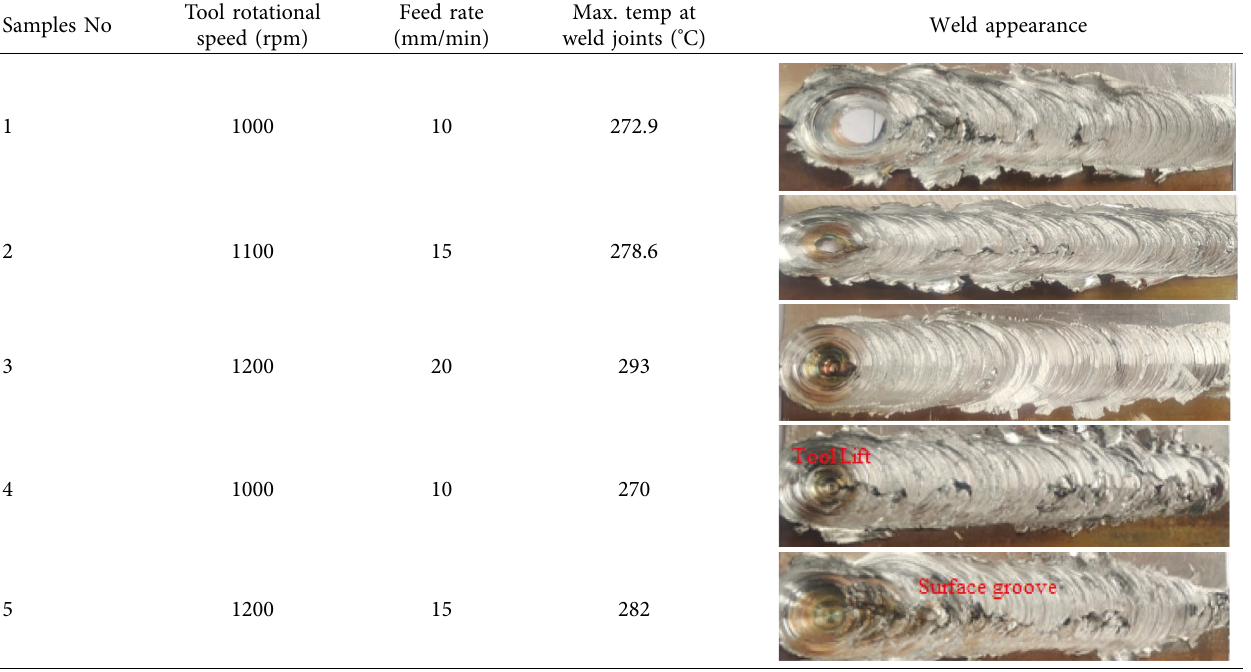
Table 6: Maximum temperature at weld regions of each trial and weld appearance after the FSW process. Samples No